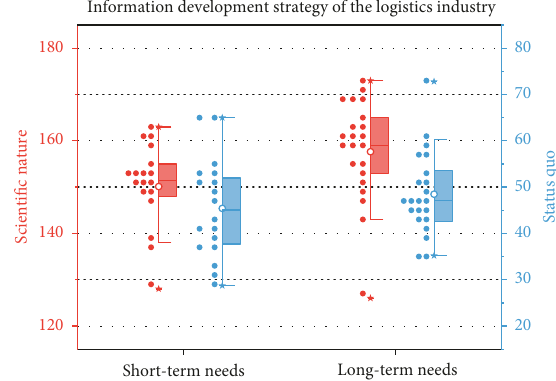
Figure 7: Frame composition of scientific nature of information